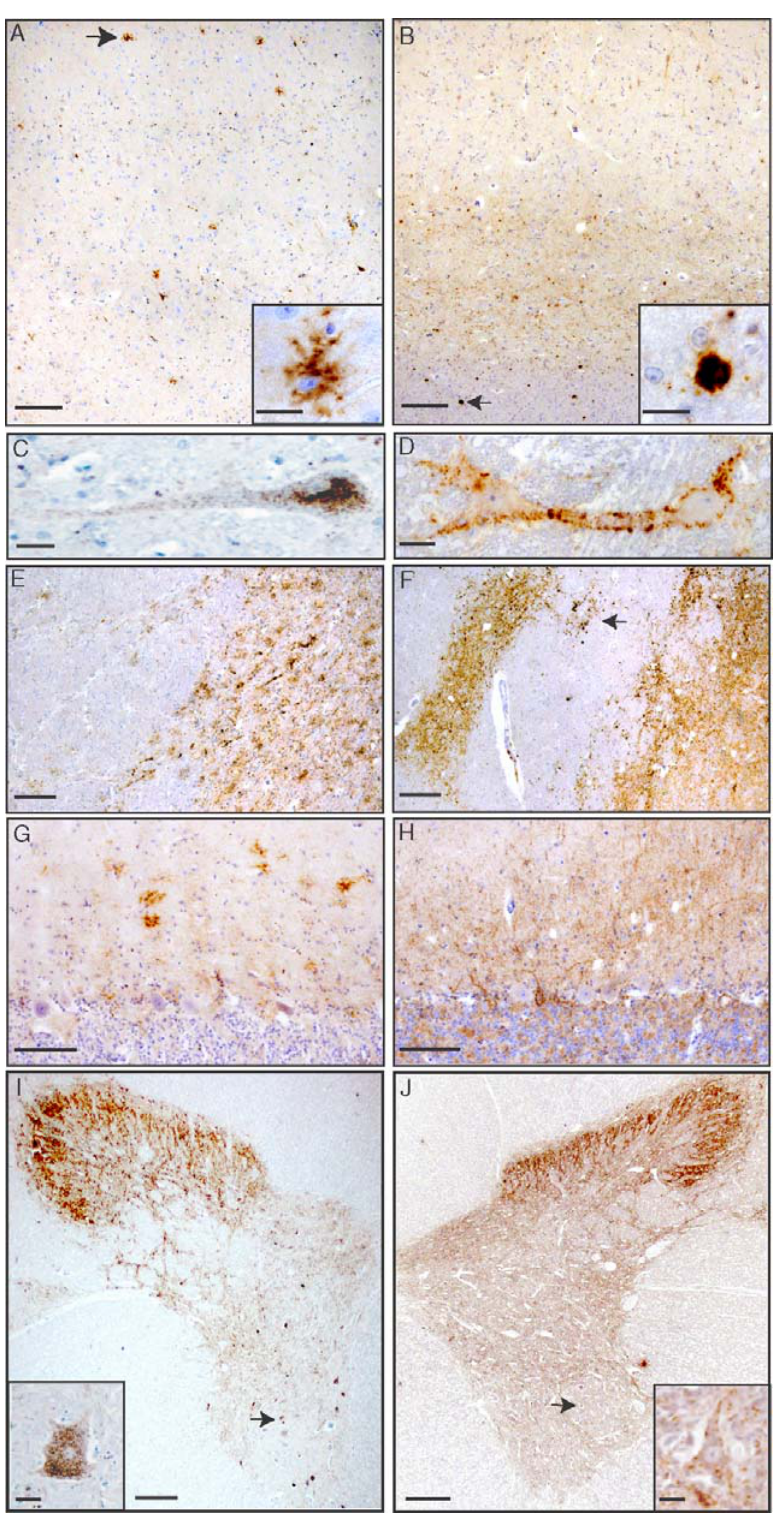
Figure 4. PrP deposition in the brain and spinal cord of BSE and BASE infected cattle. (A, C, E, G, I) BSE infected cattle, showing synaptic- punctuate and stellate patterns in (A) the frontal cortex (scale bar 100 m m), detail of stellate labelling (inset, scale bar 20 m m) and (C) detail of granular staining in the perikaryon of a cortical neuron (scale bars 20 m m); (D, D, F, H, J) BASE cattle showing (B) a diffuse synaptic-punctuate staining and abundant PrP plaques in the deeper cortical layers and in the white matter of frontal cortex (arrow, scale bar 100 m m), detail of a plaque (inset, scale bar 20 m m), and (D) of a cortical neuron (scale bars 20 m m). The different patterns of PrP deposition, in all BSE- and BASE-infected cattle, were also observed in the thalamus (E, F) and in the cerebellum (G, H), with the exception of amyloid plaques which were not observed in the cerebellum (scale bars 100 m m). PrP deposition in spinal cord mainly occurred at the level of Rexed laminae I–III, in both BSE (I) and BASE (J) infected cattle (scale bars 500 m m); motor neurons, indicated by arrows, displayed distinct patterns of PrP deposition in BSE (inset, scale bar 20 m m) and in BASE (inset, scale bar 20 m m) infected cattle (F99, 1:5000). doi:10.1371/journal.ppat.1000075.g004 PLoS Pathogens |